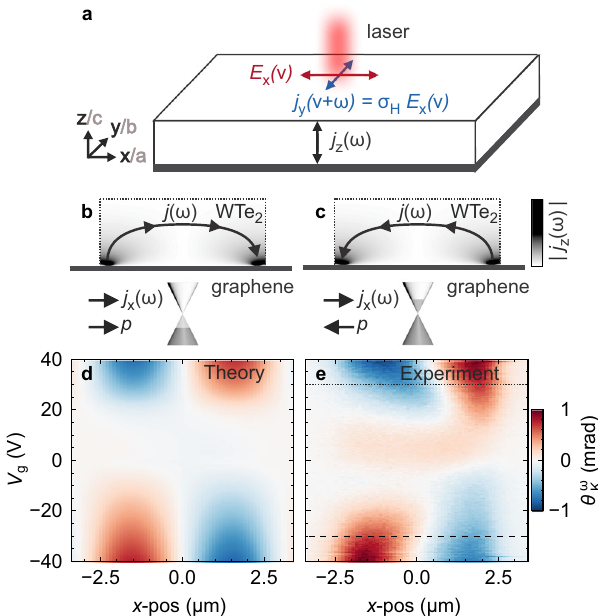
Fig. 5 Theory of current-induced KR in WTe 2 . a Schematic drawing of the electric fi elds associated with the linearly polarised laser light (red), the induced non-linear Hall response (blue), and the vertical component of the ac current fl ow (black). b , c Sketch of the current fl ow pro fi les in the WTe 2 , shown for b p -type and c n -type doping of the proximitized graphene under overall current fl ow j x in positive x -direction; p is the carrier momentum. d Theoretically calculated and e experimentally measured θ ω K ( V 13 = 3 V) as a function of x and V g . The dashed/dotted lines indicate where the spatial pro fi les in Fig. 3 were taken. The data are from the device in Fig. consider the non-linear antisymmetrised current response: